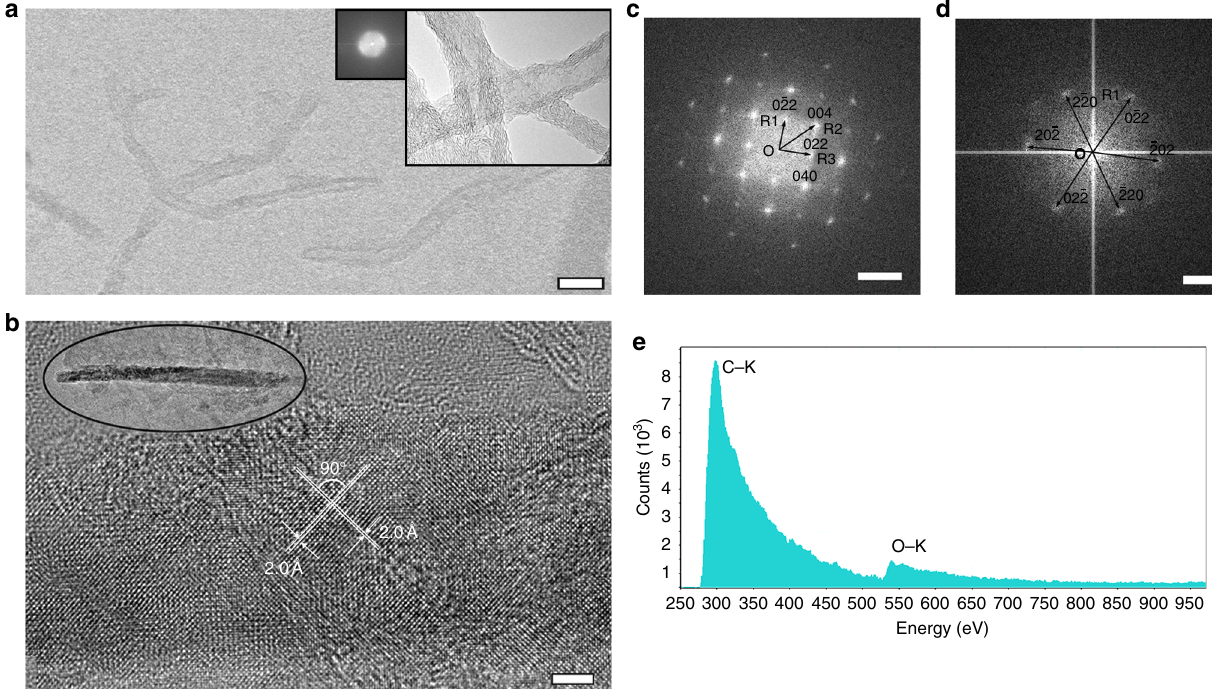
Fig. 1 Structure transformation of T-carbon nanowires from MWCNTs. HRTEM images of a shortened MWCNTs ( insets show the structure and FFT pattern of pristine MWCNTs) ( scale bar = 20 nm) and b carbon nanowire produced from laser irradiation ( inset : low magni fi cation, scale bar = 5 nm). FFT patterns of c the nanowire corresponding to b ( scale bar = 5 nm − 1 ), and d another nanowire ( scale bar = 2 nm − 1 ). e EELS spectrum corresponding to b after subtraction of carbon fi lm